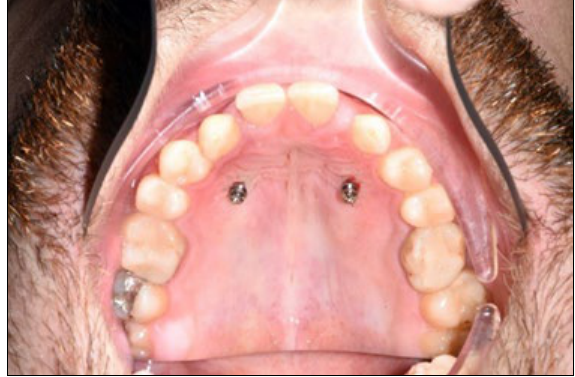
Figure 4. Postoperative view after guided insertion of